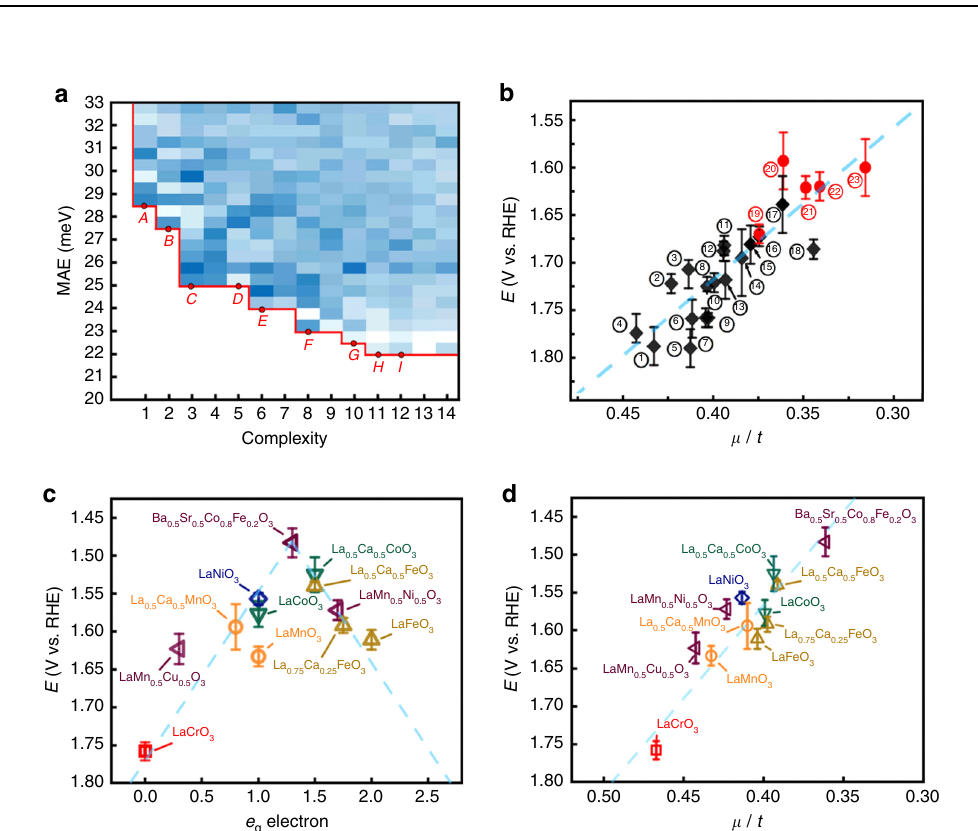
Fig. 3 Descriptor generation and performance. a Pareto front of MAE vs. complexity of 8640 mathematical formulas shown via density plot. b V RHE vs. μ / t (black diamonds: conventional perovskites; red dots: new perovskites). The current densities are normalised by BET surface areas (Supplementary Table 2) and loading amount. c Figure 2 from the study of Suntiviich et al. 9 reproduced with permission from the American Association for the Advancement of Science. d Reformatted plot according to descriptor μ /t of c . The MAE (Pearson correlation coef fi cient) for c , d were 20.6 meV (0.923) and 21.0 meV (0.928), respectively.(The error bar in b is produced by the maximum and minimum values in experiments